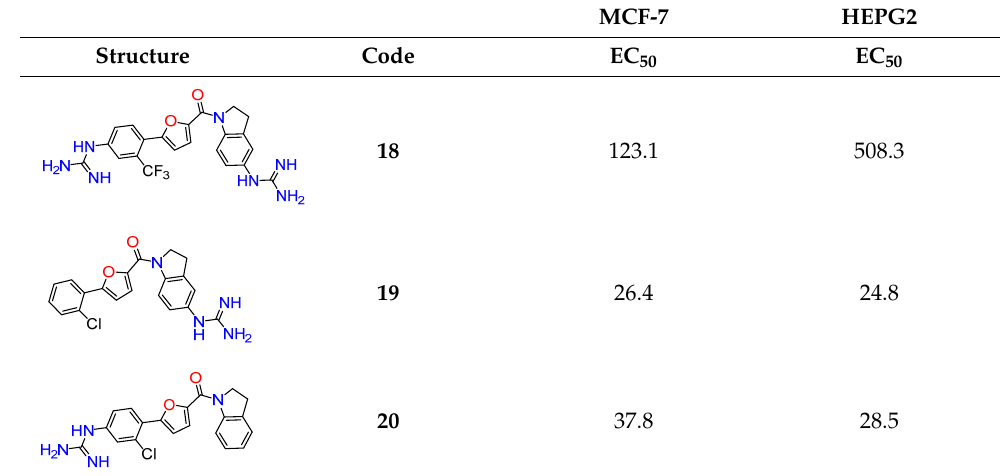
Table 2. Effective concentrations of 1 , 3 , 4 , 6 , 8 , 10 , 16 , 17 and CTX against the Gram-negative set of ESKAPE and E. coli isolates with different antibiotic susceptibility profiles.